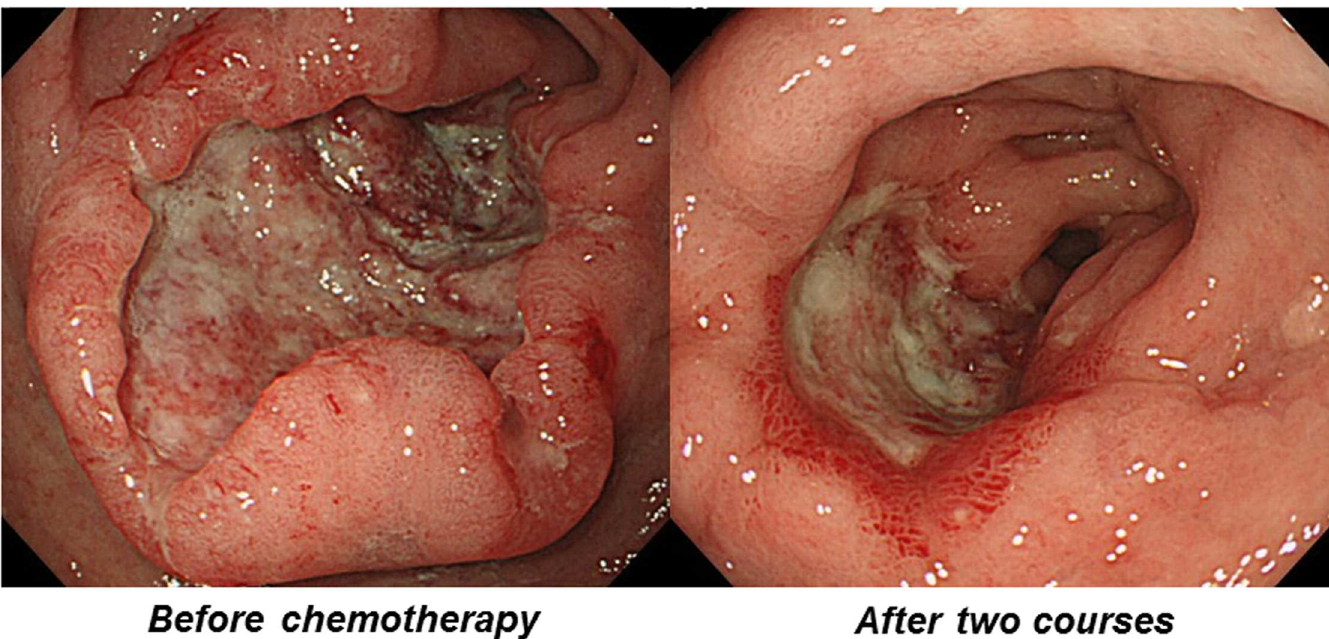
Fig 1. A representative case of GC considered to be endoscopic responder. An ulcerativelesion (type 3 tumor) showeddistinct reductionand flattening after two courses of chemotherapy.